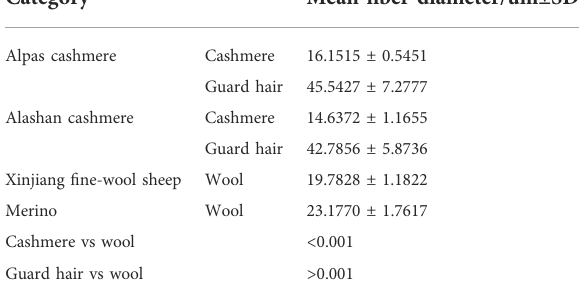
TABLE 2 Determination of fi ber